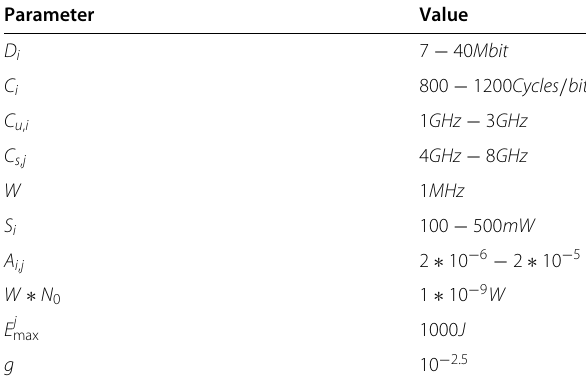
Table 2 Experimental parameter settings